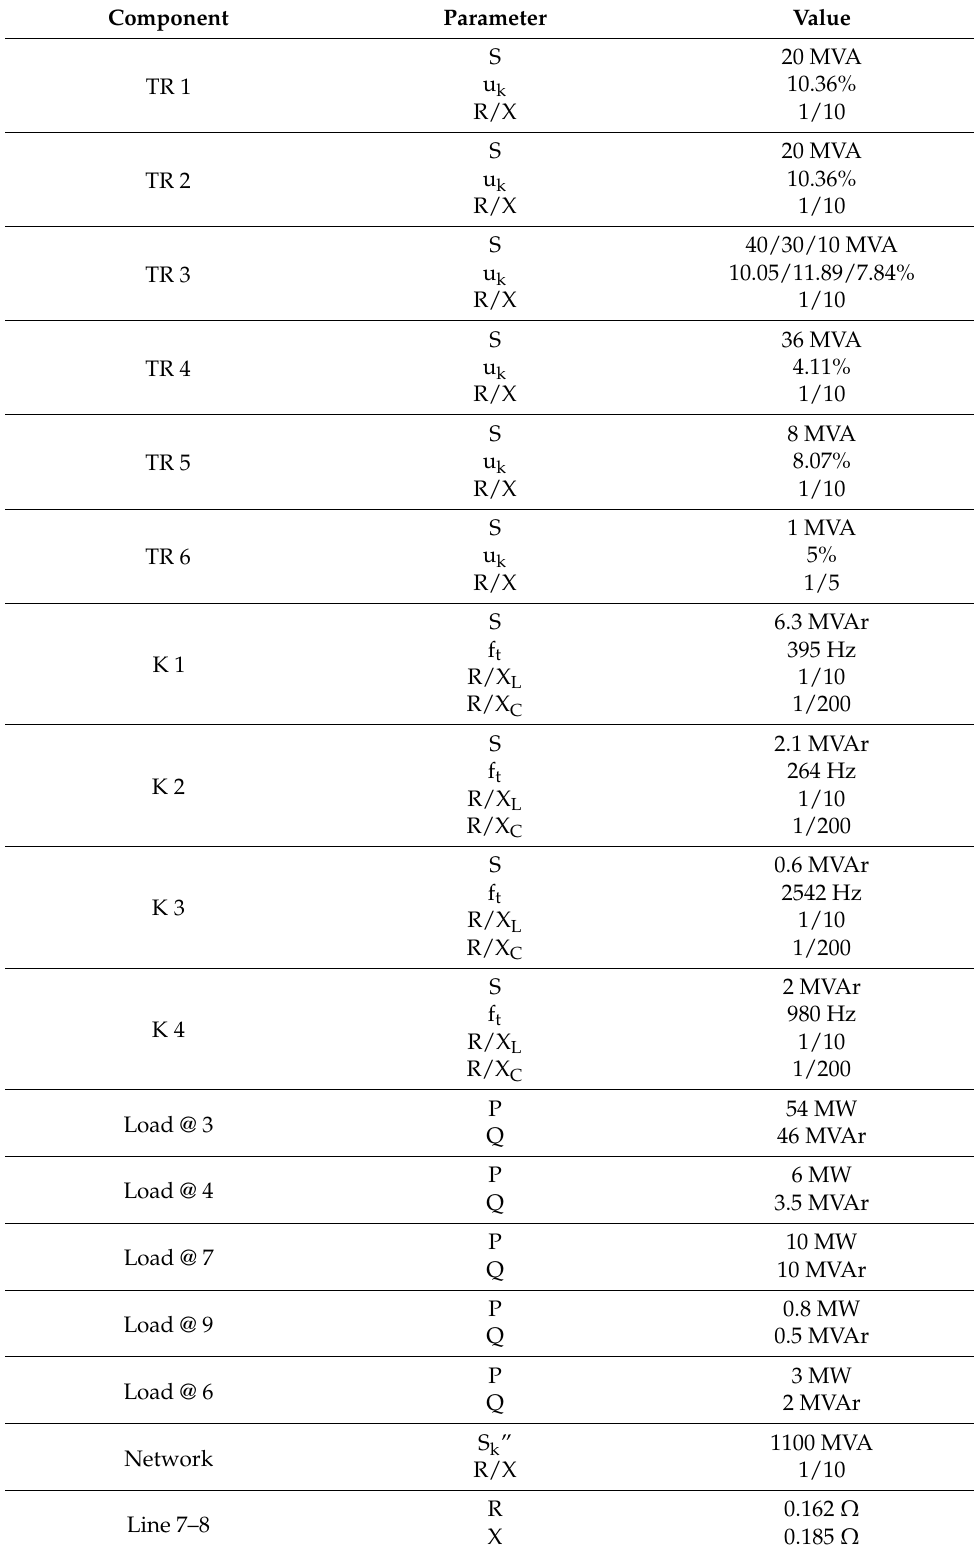
Table 1. Industrial network